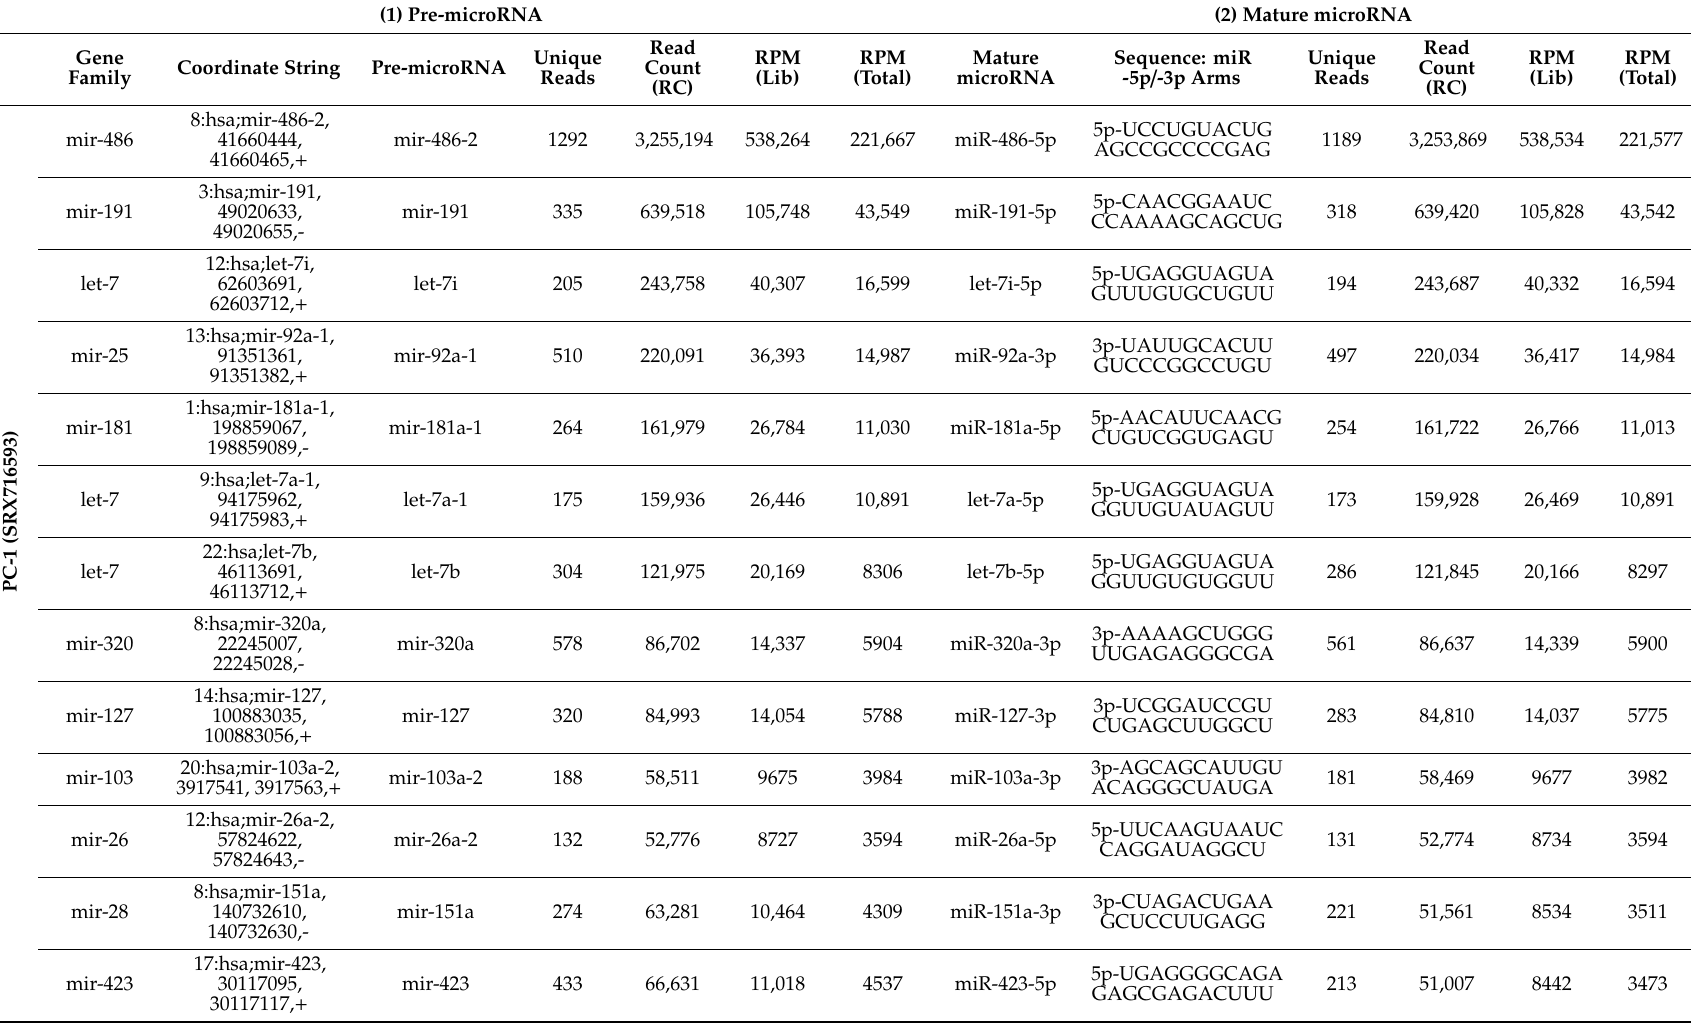
Table 2. The top-20 miRNAs most expressed in platelet